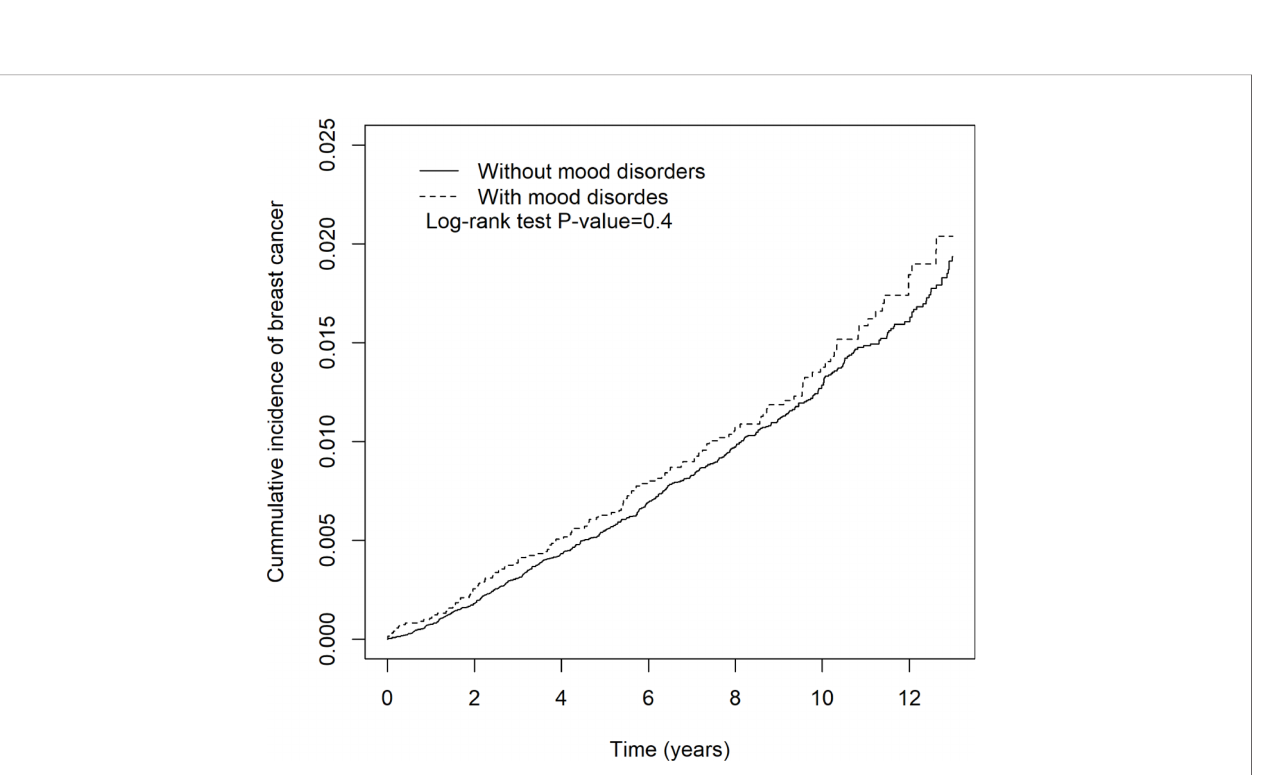
FIGURE 4 | The cumulative incidence of breast cancer in patients with and without mood